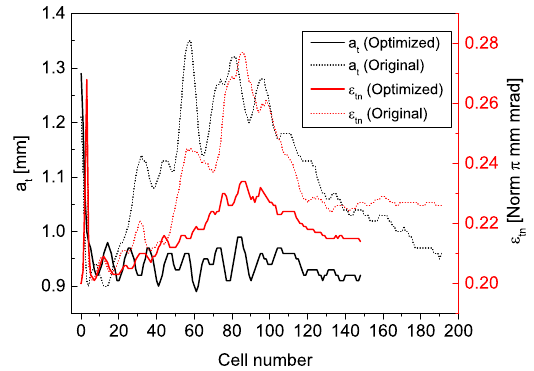
FIG. 3. Beam envelope and emittance of the original and optimized